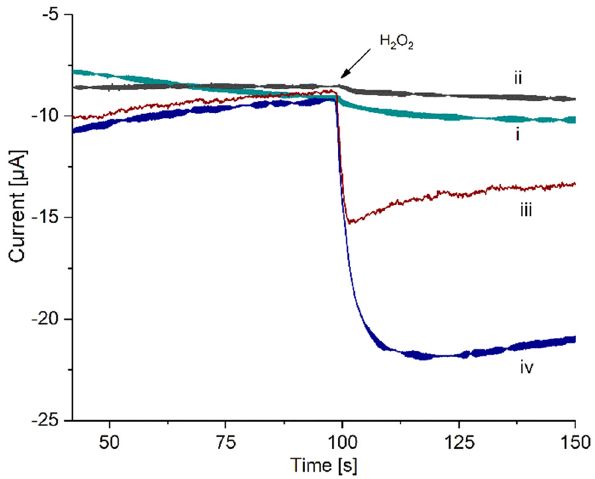
Figure A5: Amperometric response towards H 2 O 2 addition on ( i ) SPCE/PAni, ( ii ) SPCE/PAni/AuNP, ( iii ) SPCE/PAni/AuNP/cMWCNT, and ( iv ) SPCE/PAni/AuNP/cMWCNT/CAT biosensor.